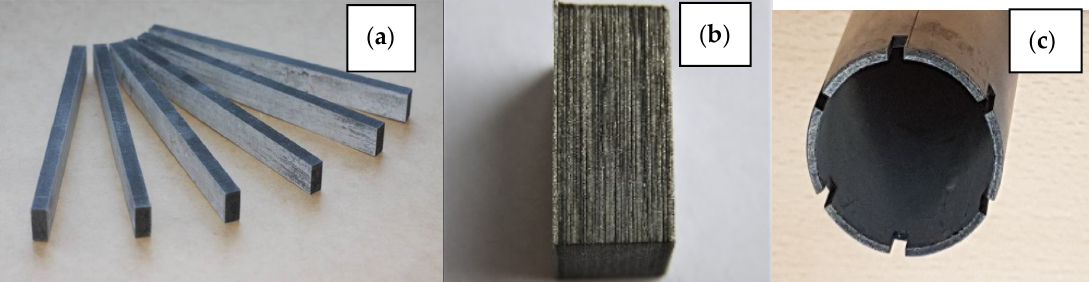
Figure 8. Elements for grinding and polishing devices: honing stones 6 × 10 × 120 mm ( a , b ); ring drill Ø 45 mm ( c ).